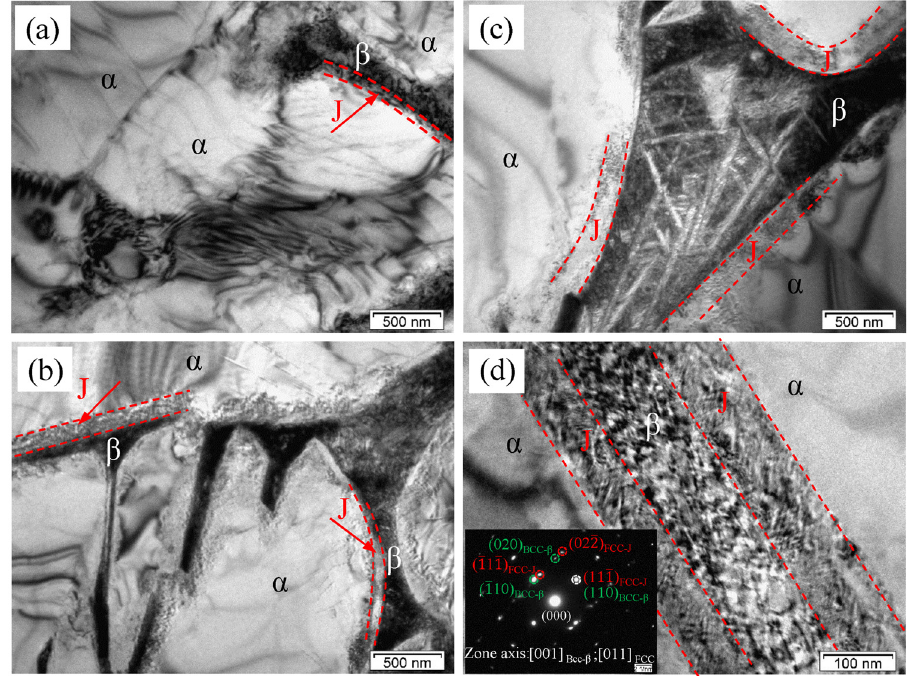
Figure 2: TEM micrographs of Ti80 alloy: ( a ) forged state ( α and α grain region ) , ( b ) equiaxed state ( trigeminal grain boundary region between equiaxed α grains ) , ( c ) bimodal state ( α and α + β region ) , and ( d ) lamellar state ( lamellar α + β region )